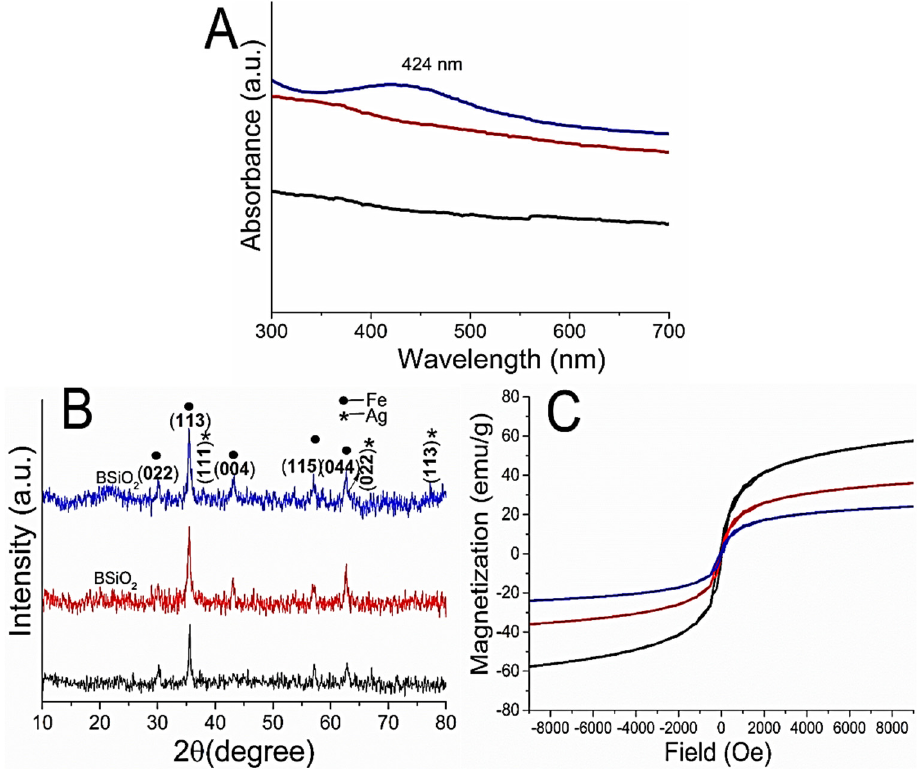
Figure 3. ( A ) UV-visible spectroscopic analysis of Fe 2 O 3 NPs, BSiO 2 -Fe 2 O 3 particles, and Ag-BSiO 2 - Fe 2 O 3 structure. ( B ) XRD analysis. ( C ) Magnetization curves of γ -Fe 2 O 3 NPs (black), BSiO 2 -Fe 2 O 3 particles (red), and Ag- BSiO 2 -Fe 2 O 3 structure (blue).